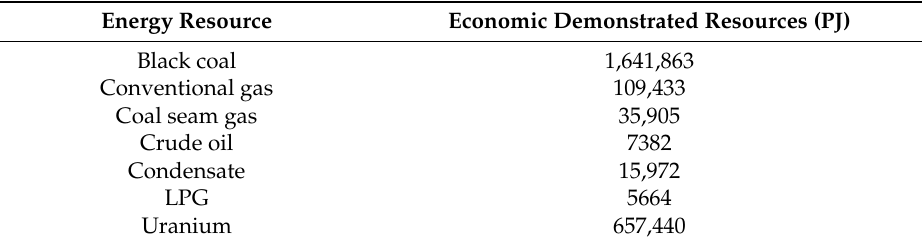
Table 2. Australia’s Economic Demonstrated Resources (EDR) * as of December 2012